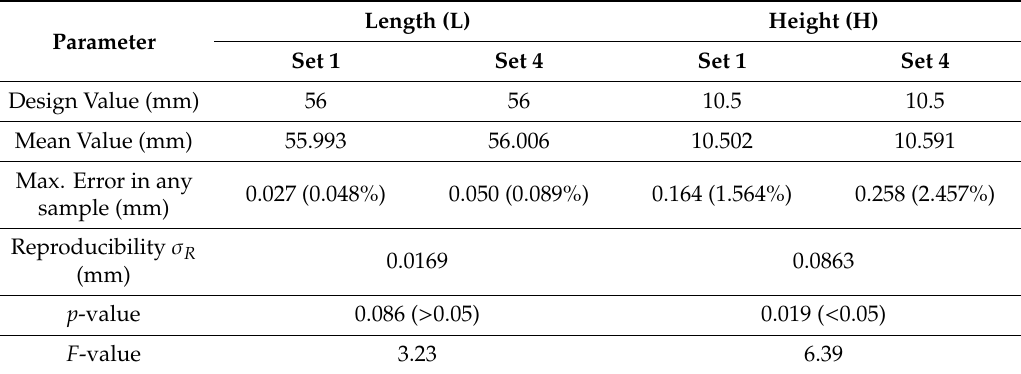
Table 2. Measurement and ANOVA results of set 1 and set 4 developed under reproducibility